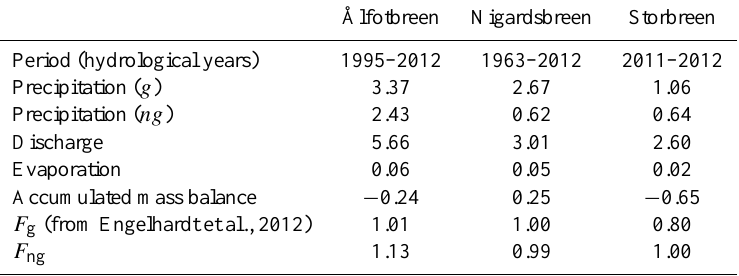
Table 2. Water balance components (in ma − 1 ) and precipitation correction factors ( F ) for the glacierised (g) and non-glacierised (ng) parts of the three catchments. All water balance components are specific quantities for the respective catchment area (Table